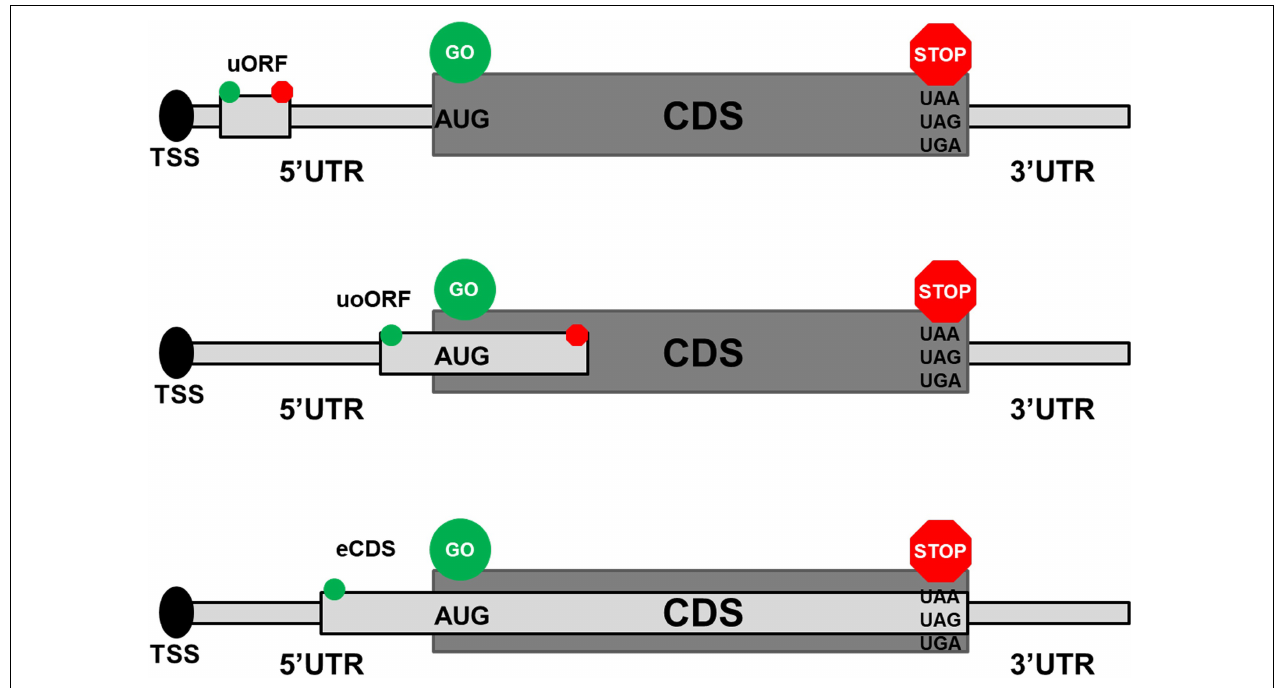
FIGURE 1 | Different types of upstream open reading frames (upORFs) located in the 5 (cid:48) UTR of coding transcripts. The upper, middle, and lower panels show the position on coding transcripts of fully upstream ORF (uORF), overlapping ORF (uoORF), and elongated coding sequence (eCDS), respectively. The start and stop codons associated to the described upORF are indicated by green and red circles, respectively. AUG corresponds to the canonical start codon and UAA, UAG, and UGA correspond to the stop codons. TSS, transcription start site; UTR, untranslated region; CDS, coding sequence.